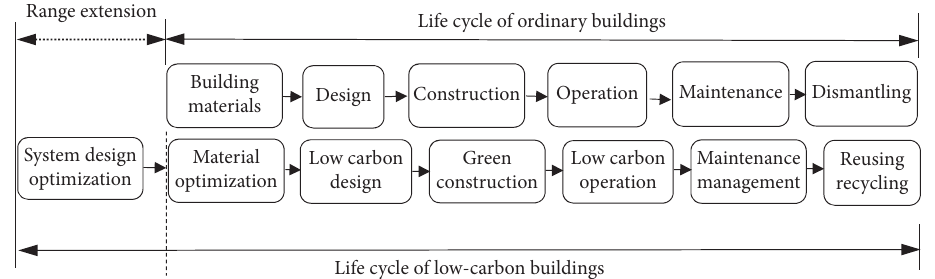
Figure 1: Life cycle division of low carbon